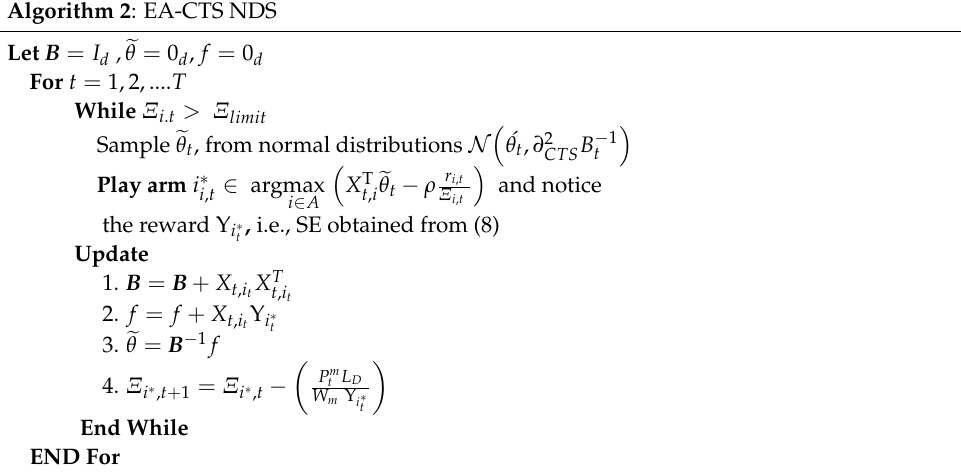
Algorithm 2 : EA-CTS